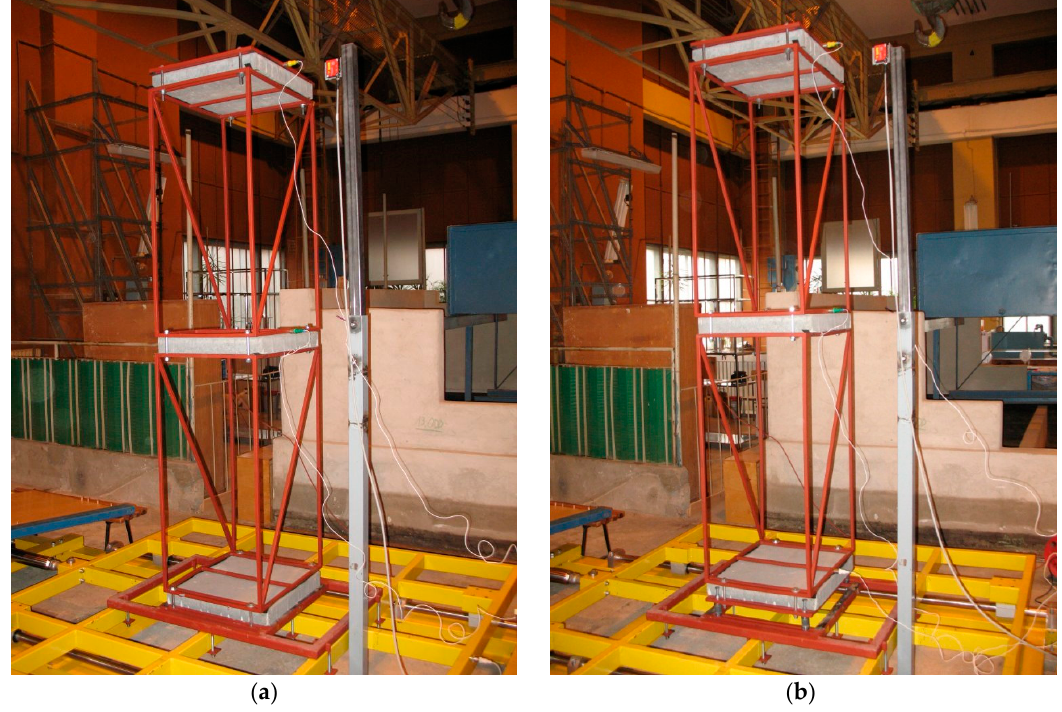
Figure 8. Fixed-base ( a ) and base-isolated ( b ) two-storey structure model.